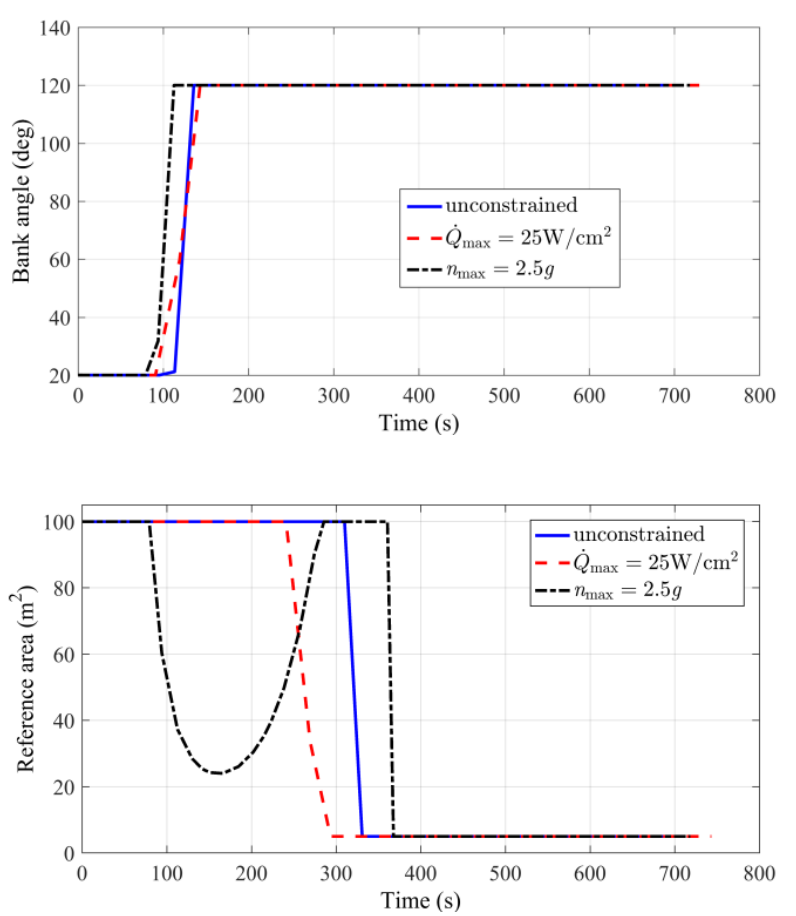
Figure 7. Bank angle and reference area profiles with different path constraints.